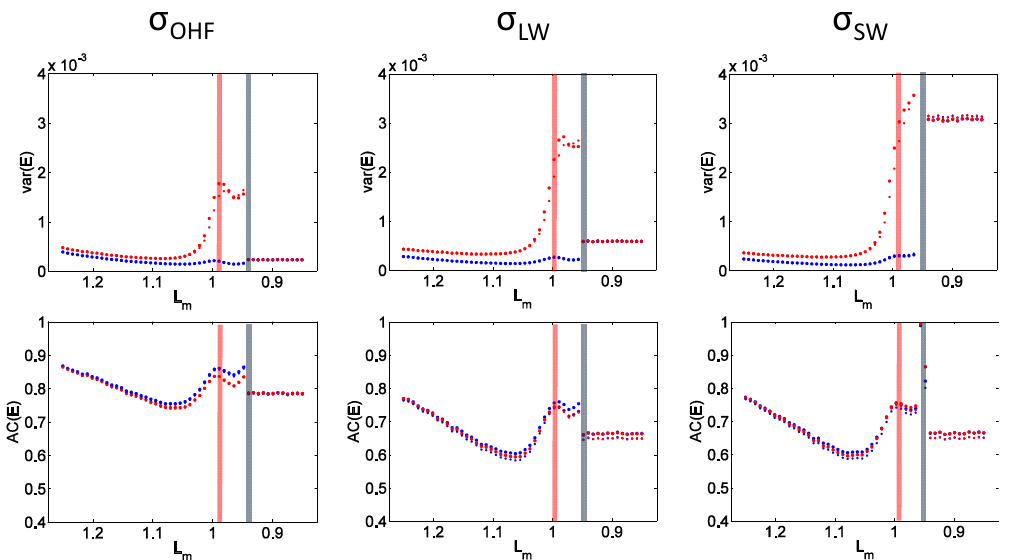
Figure 4. Variance (var) and autocorrelation (AC) of state E as a function of long-wave balance L m in the model E12 with large red noise. In each column, the noise term has been introduced to one of three different terms, namely the ocean heat flux (OHF), long-wave radiative balance (LW), and short-wave radiative balance (SW). Winter sea ice is shown in blue and summer sea ice in red (seasons as in Fig. 1). The vertical shaded lines indicate the values of L m where the annual minimum (red lines) and maximum (blue lines) ice volume reaches